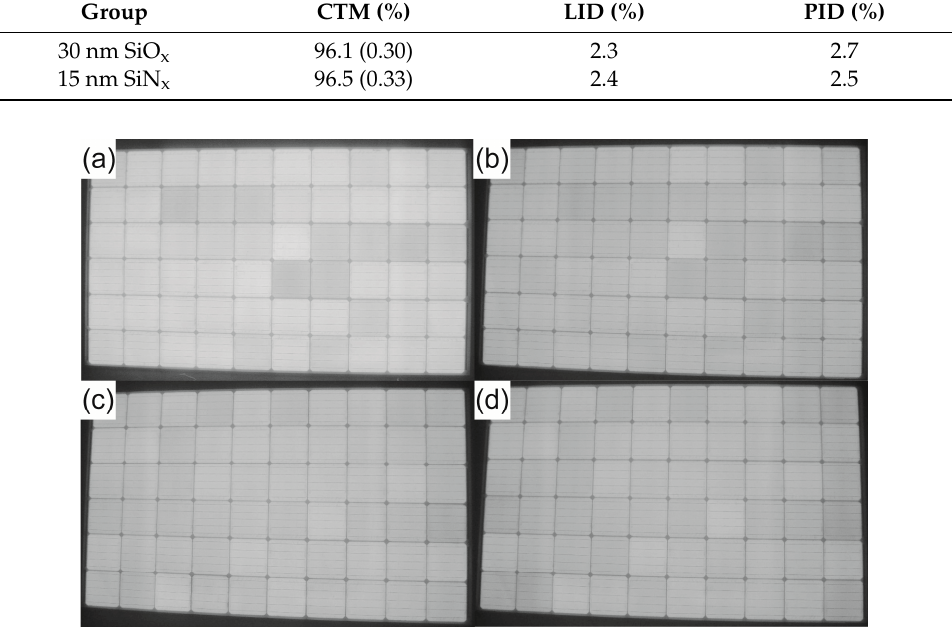
Figure 6. Electroluminescence images of monocrystalline silicon PERC solar modules with 30 nm SiO x as the third layer of antireflection coating before and after the LID test ( a,b ) or PID test ( c,d ).